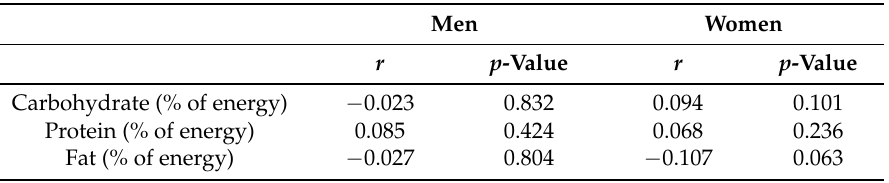
Table 5. Partial correlation coefficients between eating behaviors and REE.